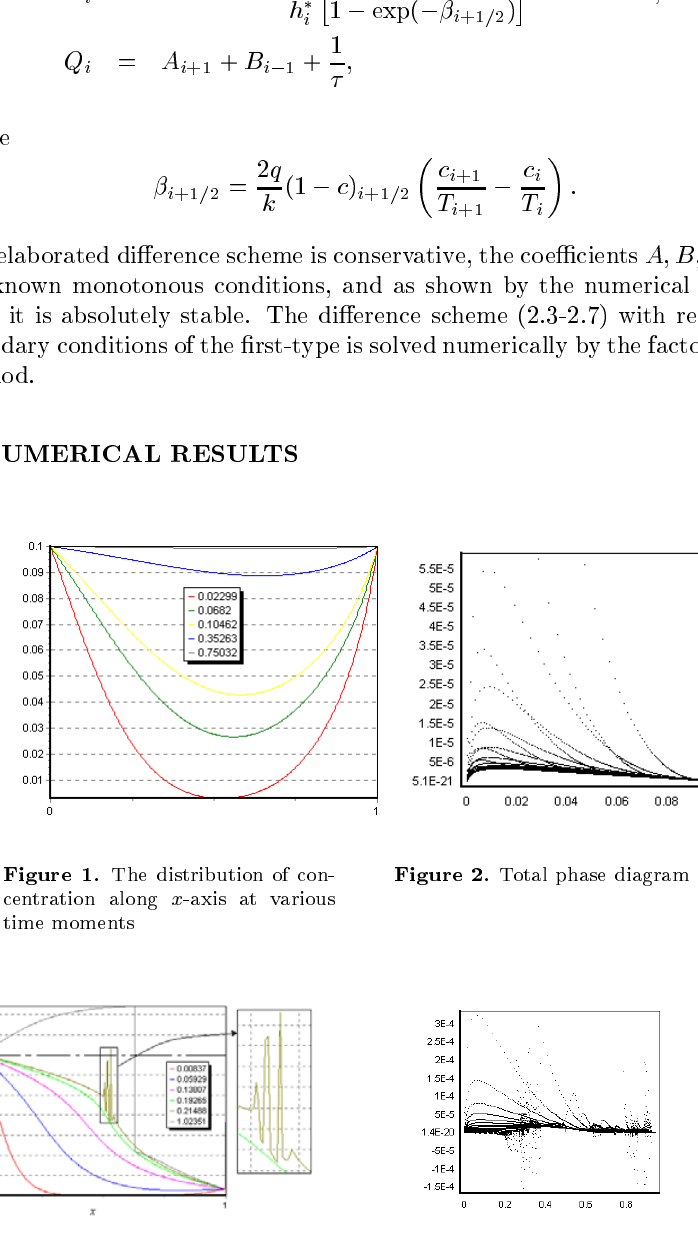
Figure(cid:3)(cid:1)Thedistributionofconcentration